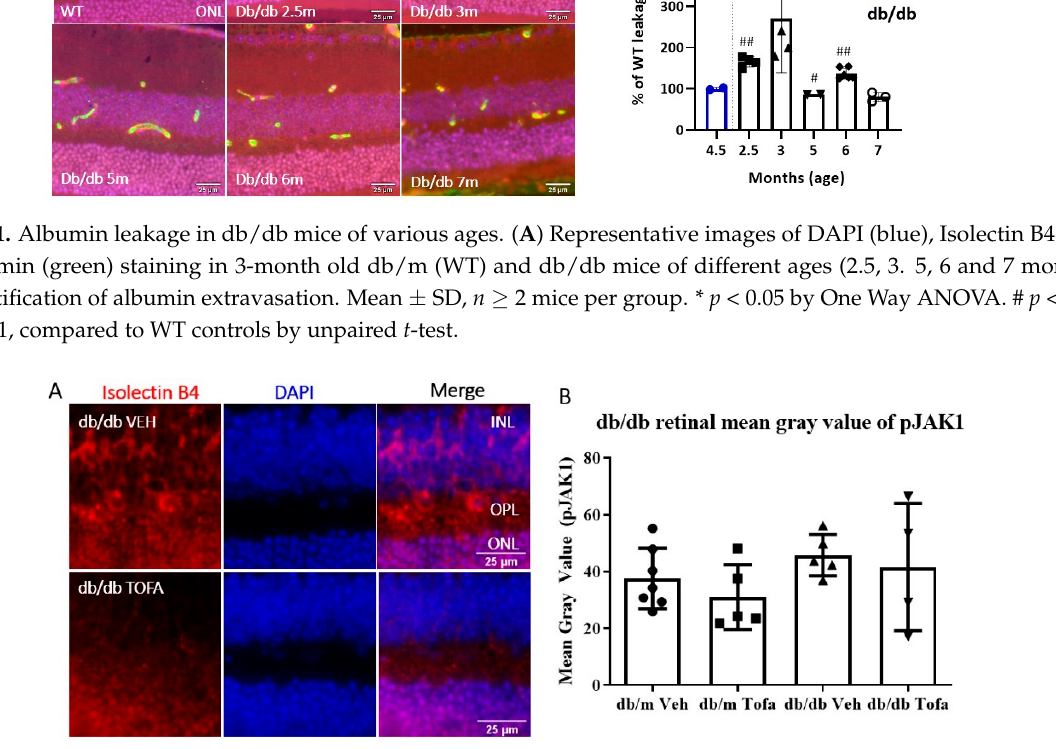
Figure A2. The effect of tofacitinib citrate treatment on pJAK1 expression in the retinas of db/db and db/m mice. 2.5-month old db/db and db/m mice were treated with tofacitinib daily for 2 weeks. Eyes were collected for pJAK1 staining. ( A ) Representative immunofluorescence of db/m and db/db retinas showing pJAK1 (red) and DAPI (blue). INL—inner nuclear layer; OPL—outer plexiform layer; ONL—outer nuclear layer. ( B ) Quantification of pJAK1 mean gray value in the neuroretina. Tofa = tofacitinib citrate, Veh = vehicle control.